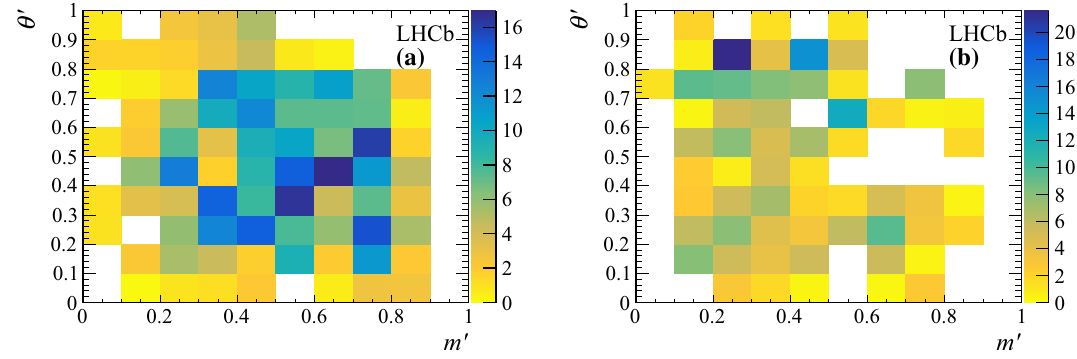
Fig. 5 SDP distributions used in the DP fit to the Run 2 subsample for a combinatorial background and b NR B 0 → ppK + π − background